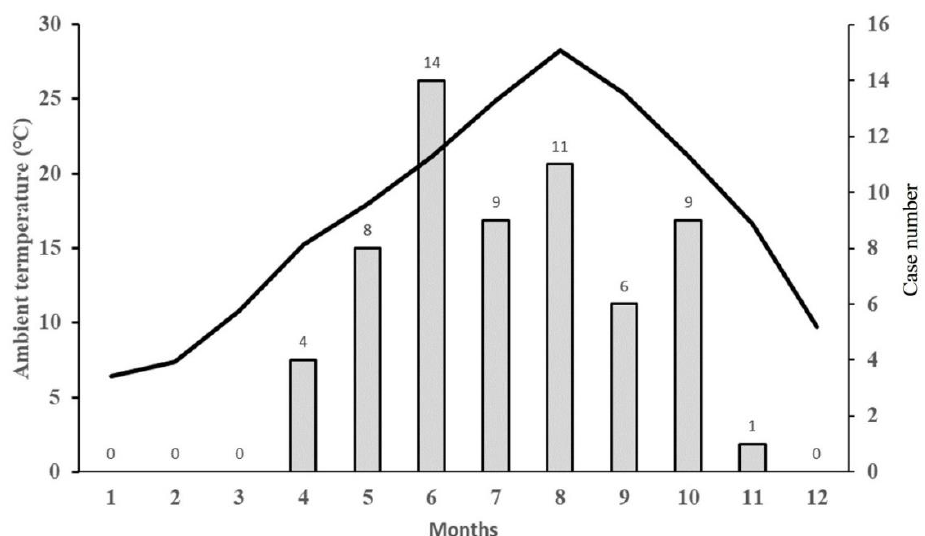
Figure 3. Relationship between monthly mean ambient temperature and incidence of patient with severe fever with thrombocytopenia syndrome. The black line indicates the mean monthly ambient temperature on Jeju Island (2013–2019). The gray bars indicate the monthly total incidence cases of SFTS in patients on Jeju Island (2013–2019).